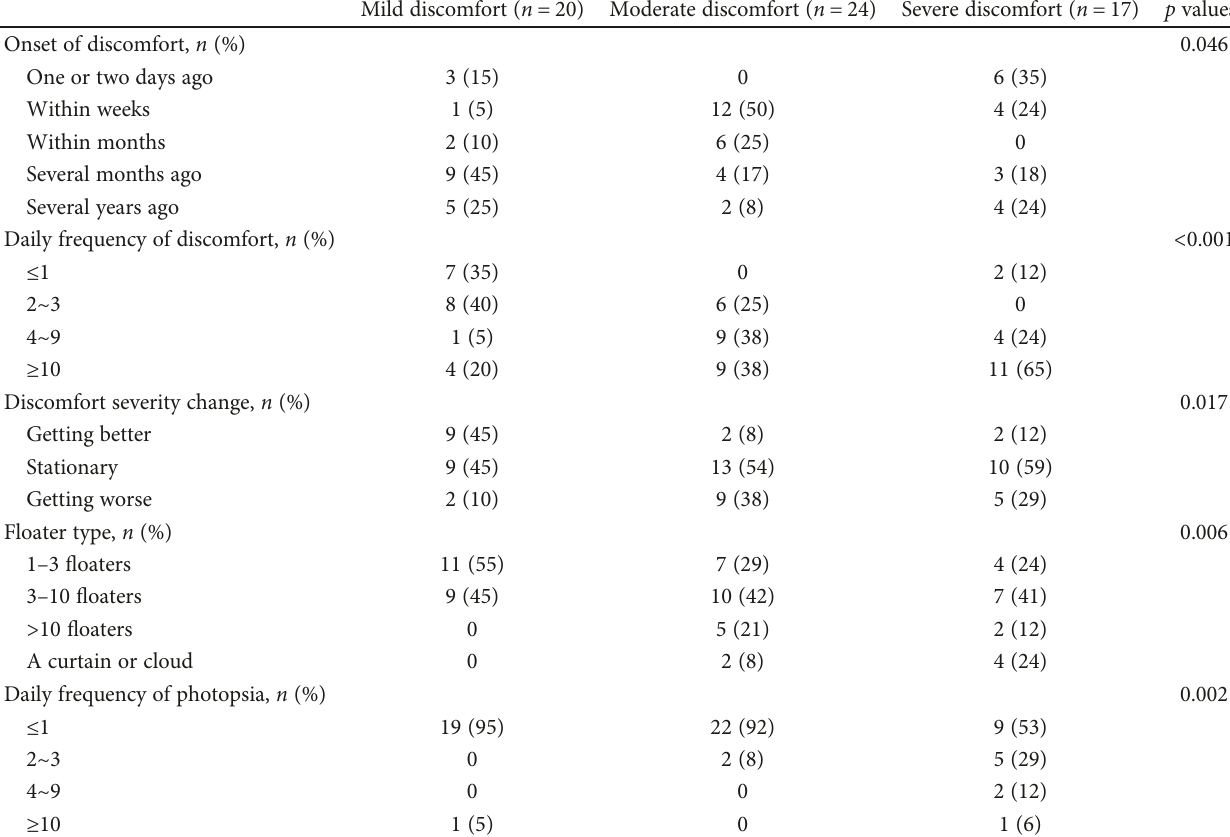
Table 4: Comparison of characteristics of vitreous fl oater symptoms according to the degree of